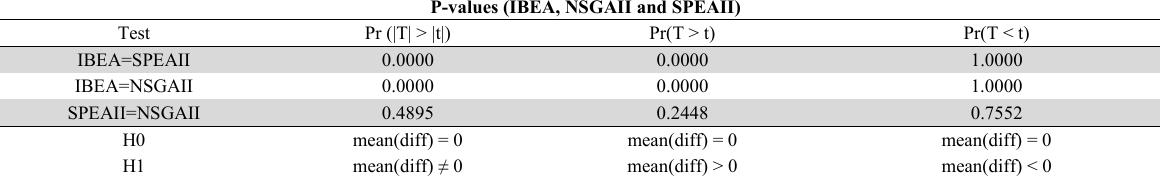
P-values in the difference of means test between IBEA, NSGAII and SPEAII. P-values (IBEA, NSGAII and